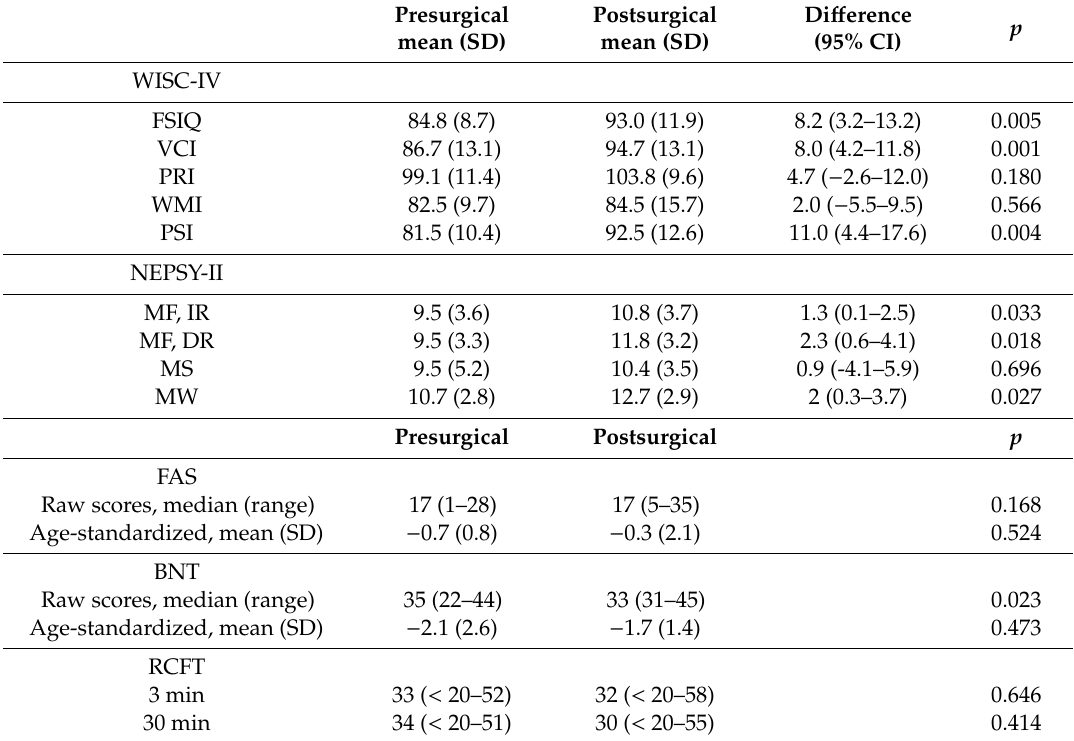
Table 2. Pre and postsurgical neuropsychological test